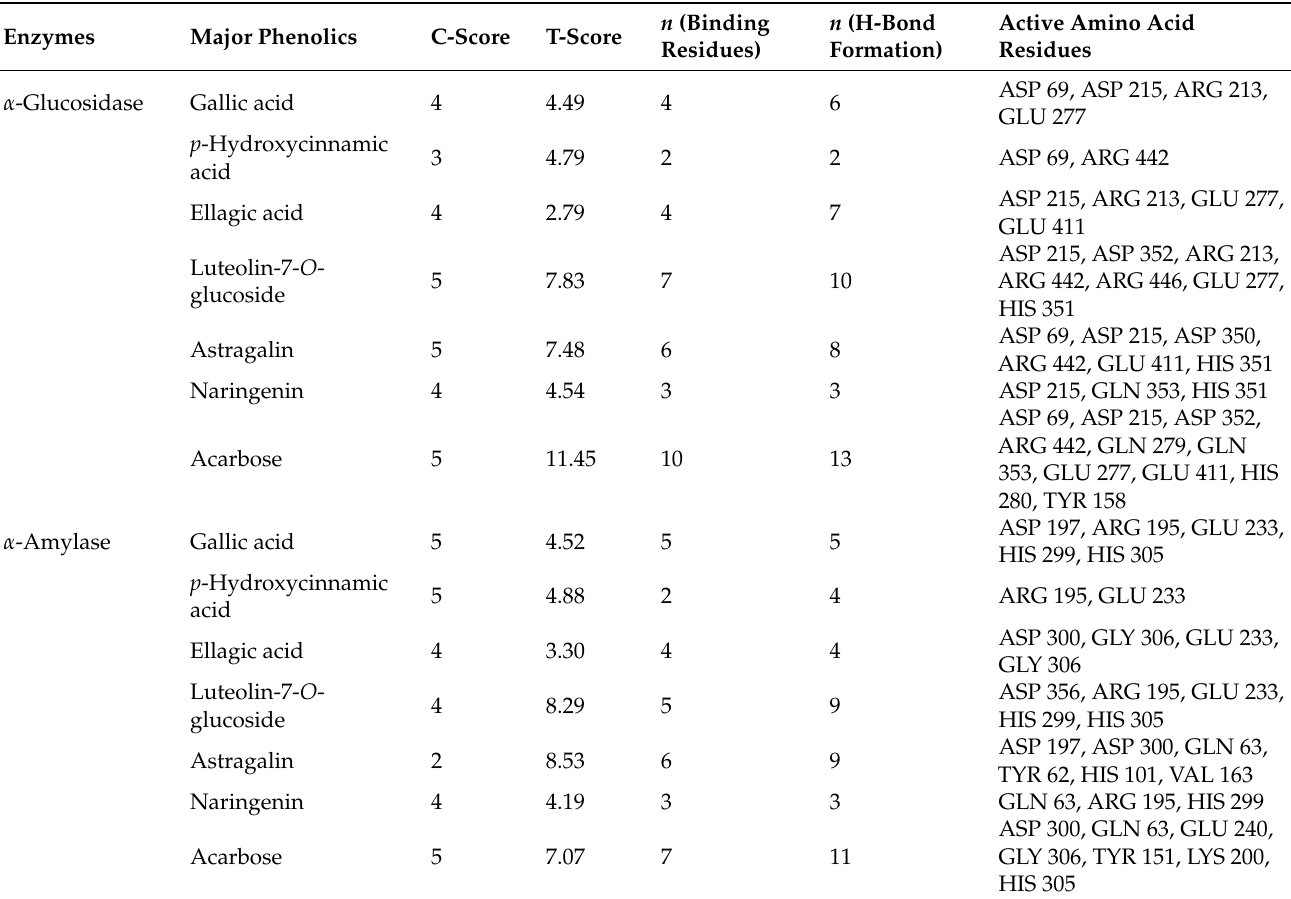
Table 5. The analysis results of the major phenolic compounds and controls docking with α - glucosidase or α -amylase.